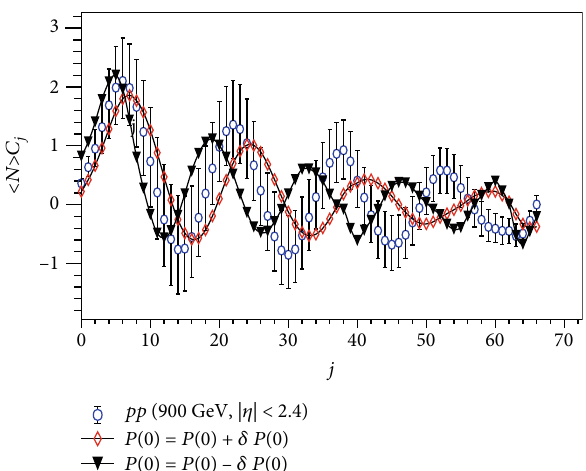
Figure 10: Illustration of oscillatory behaviour of the coe ffi cients C using error limits on the probability P ð 0 Þ .